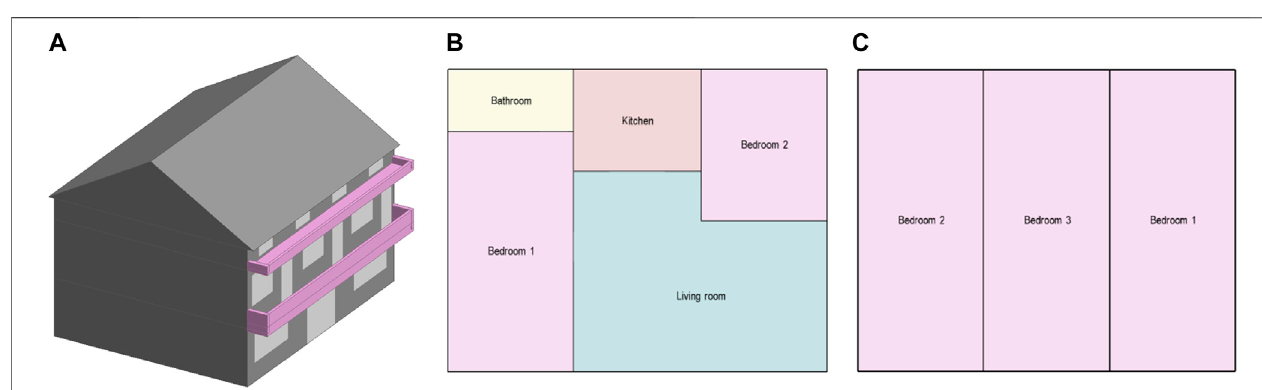
FIGURE 3 | Model of the detached house: (A) 3-D model; (B) plan of fi rst fl oor; (C) plan of second fl oor.